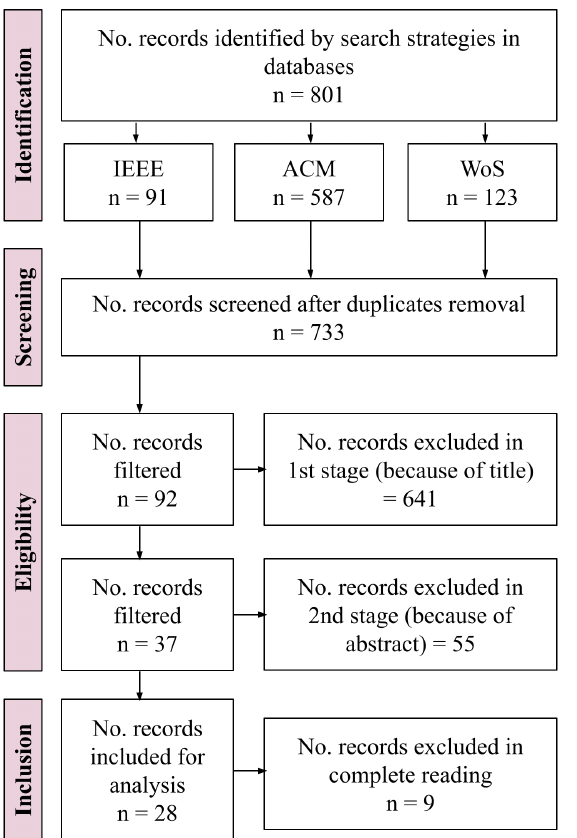
Figure 1. Flow chart of systematic review for text summarization in the biomedical